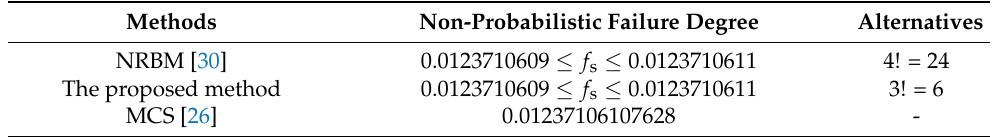
Table 4. Reliability analysis results for numerical example 2.